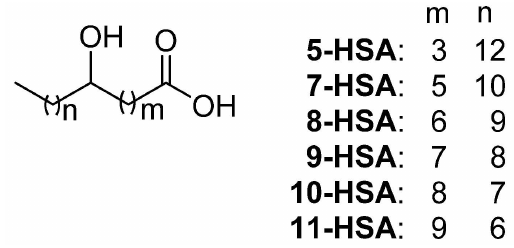
Figure 1. Hydroxystearic acids considered in current